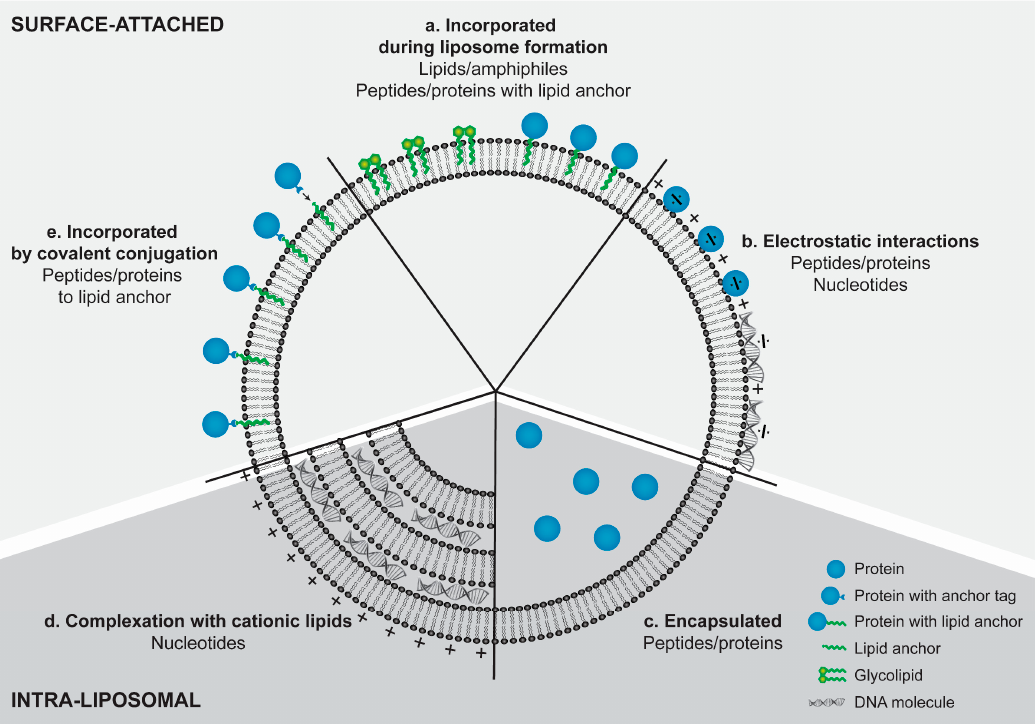
Figure 1. Different strategies can be employed for incorporating antigens and immunostimulators into liposomes depending on the type and purpose of the molecules in question. The formulation and structure of the liposomes allows the incorporation of different molecules by different strategies into the same liposomes and the precise tailoring of the adjuvant towards a certain target. ( a ) Hydrophobic molecules and lipids can be incorporated into the lipid bilayer by addition to the dissolved lipids prior to dry film formation. ( b ) Peptides/proteins and nucleotides can be electrostatically adsorbed to oppositely-charged lipids on the surface of liposomes. ( c ) Peptides and proteins can be encapsulated into the aqueous interior of the liposomes, e.g., by the dehydration-rehydration method. ( d ) Nucleotides can be complexed with cationic lipids being embedded between multiple lipid bilayers. ( e ) Post-liposome manufacture attachment of peptides and proteins can be achieved by covalent conjugation to functionalized lipid anchors.